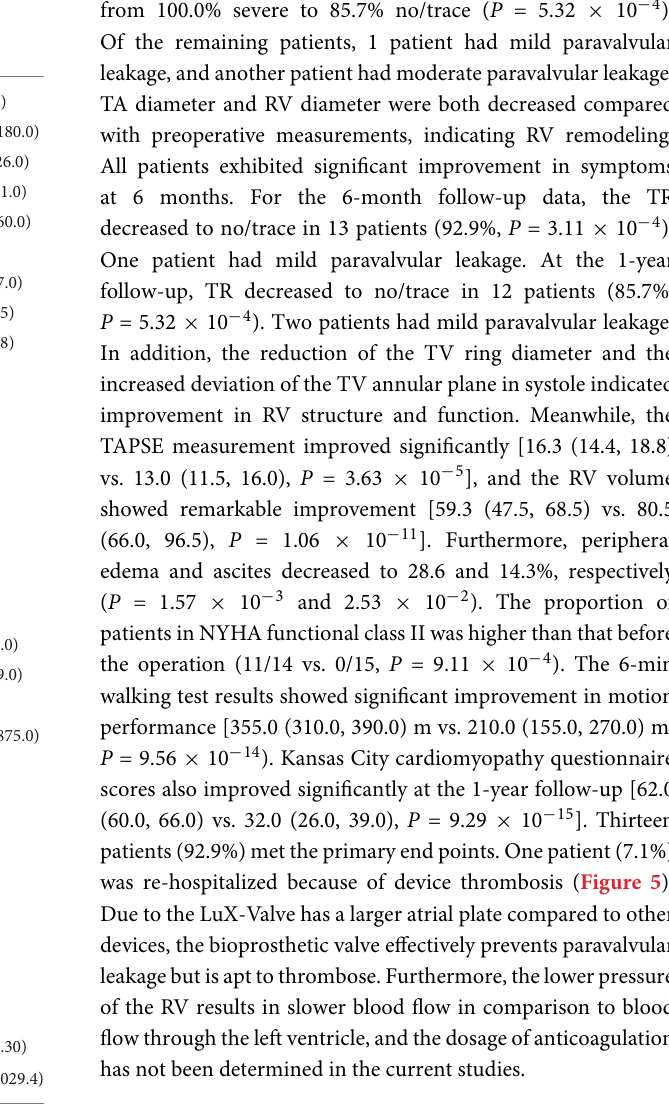
TABLE 3 Intraoperative and in-hospital outcomes ( N =